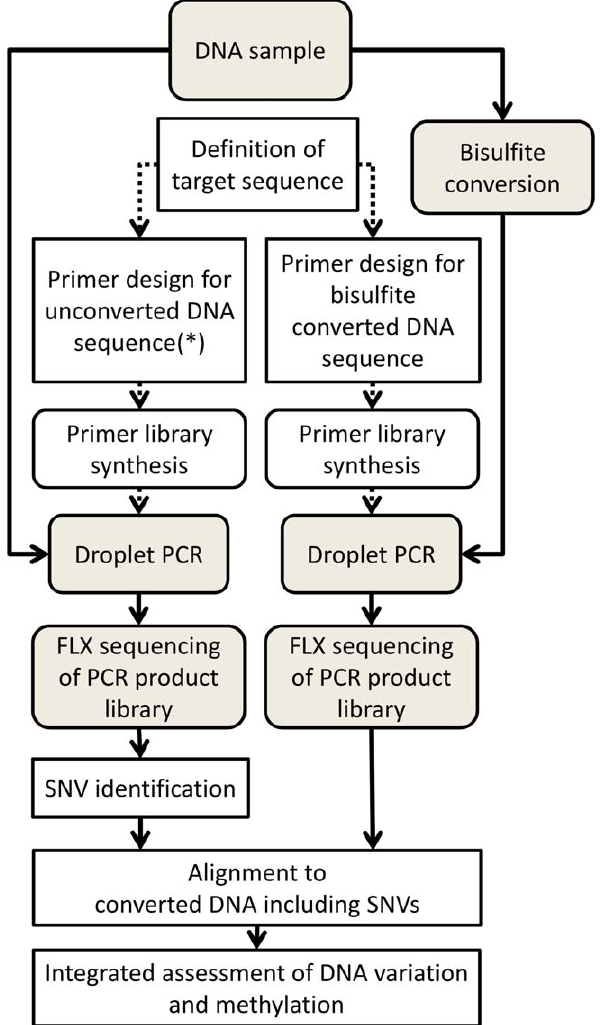
Figure 2. The Figure provides a flow chart of the pipeline for integrated analysis of DNA variation and methylation analysis as described in this manuscript. The standard design pipeline for unconverted DNA [32] is marked with an asterisk (*).